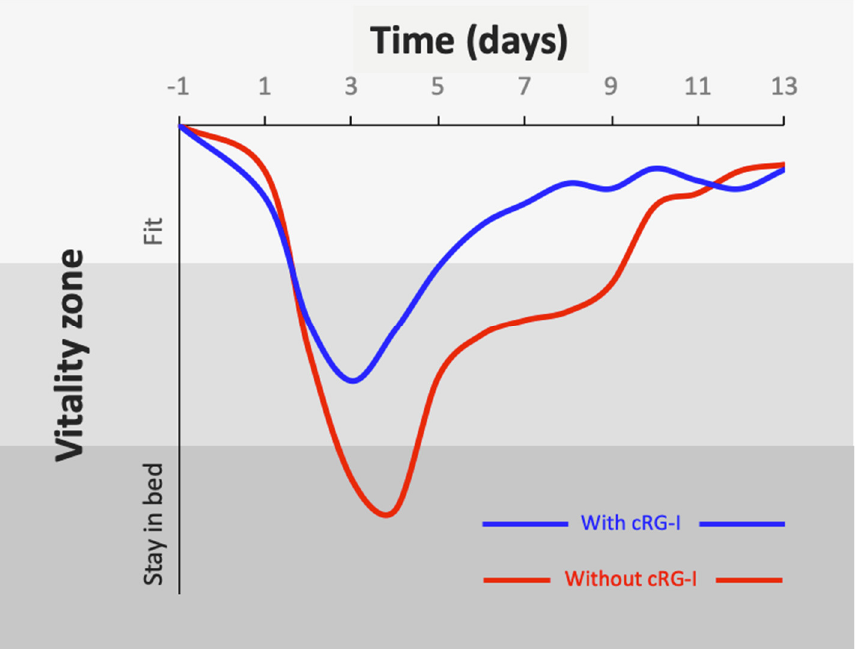
Figure 8. Exposure to an (experimental) rhinovirus infection initiates innate anti-viral and immune responses, which is accelerated by prior consumption of 0.3 g/d cRG-I. Inversion of the WURSS-21 score (score = zero on d-1), expressed conceptually as a “vitality zone”, demonstrates the mitigating effect of 0.3 g/d cRG-I on vitality in response to the impact of a common cold infection (infection on d0), thus visualizing the increased resilience to a respiratory infection.